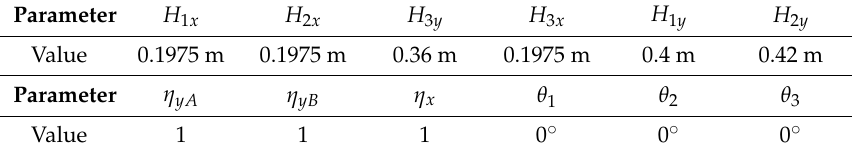
Table 1. The designed values of parameters in Hall sensor array.